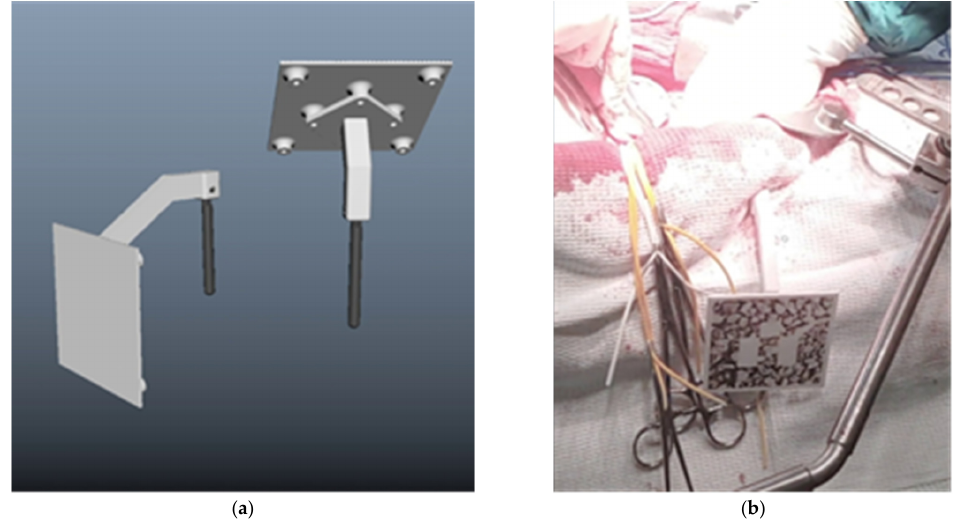
Figure 4. ( a ) Two configurations of the marker for augmented reality; ( b ) Sterilized and installed marker of the first (“abdominal”) configuration.